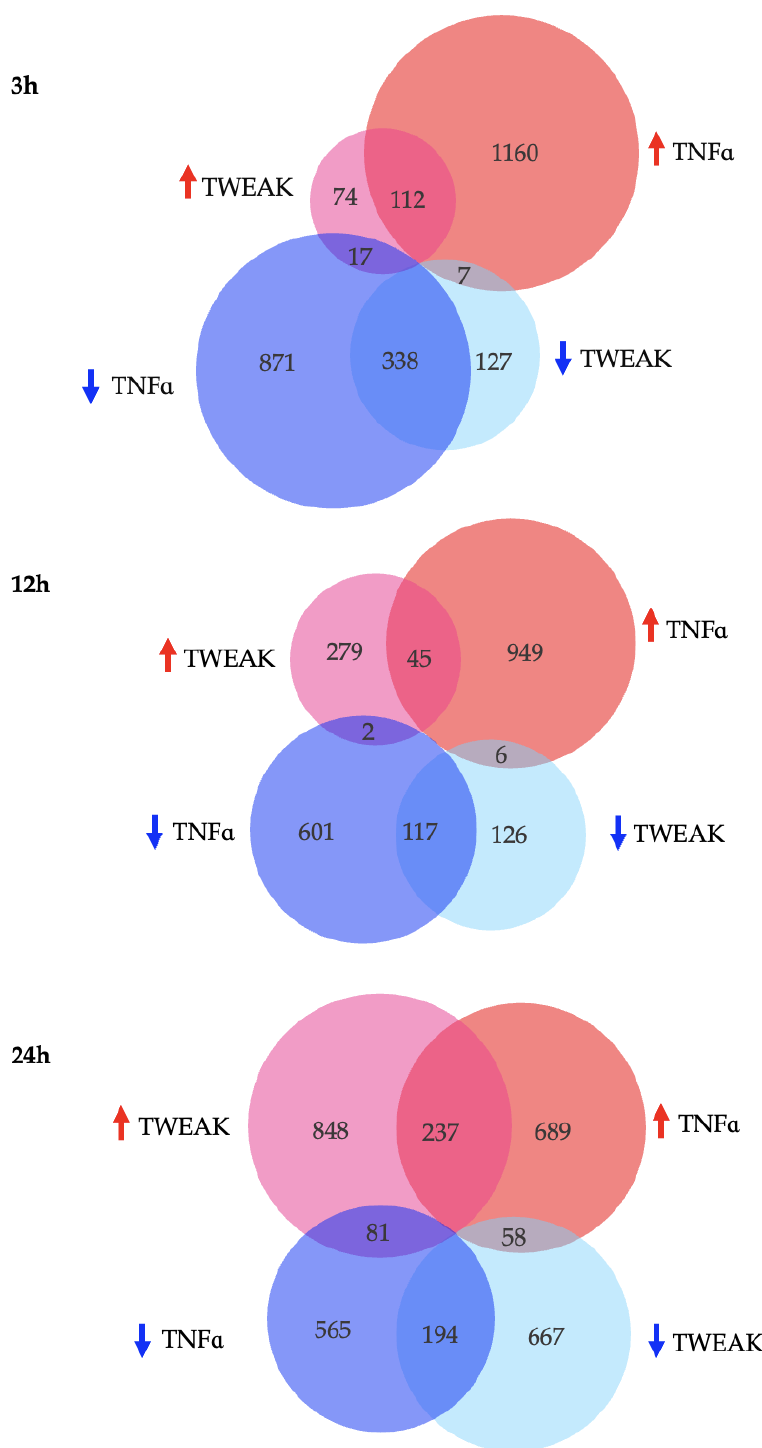
Figure 2. Number, distribution and directionality of shared and unique DEGs for hCMEC/D3 cells treated with TWEAK or TNF α after 3 h, 12 h, and 24 h. Pink (TWEAK) and Red (TNF α ) circles: upregulated genes (FC > 1.5), turquoise (TWEAK) and blue (TNF α ) circles: downregulated genes (FC < −1.5).